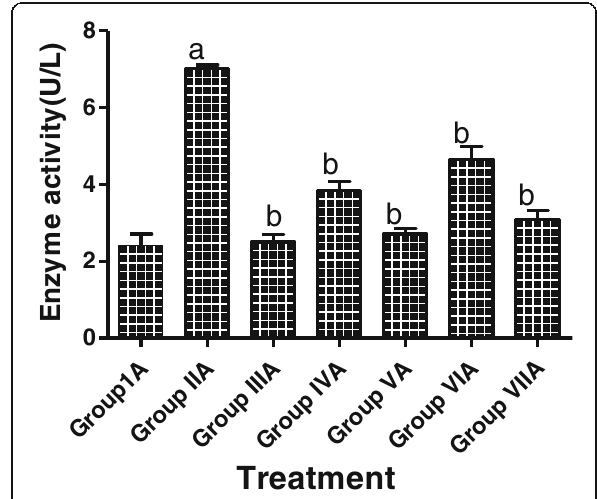
Fig. 2 Effect of methanol extract of T. conophorum seeds on Gamma gtutamyl transferase activities in CCl 4 induced hepatotoxicity in rats after 24 h of intoxication. Values are Mean±SEM, n =5 rats in each group. p <0.05, a as compared with the normal control group; b as compared with the CCl 4 only (group IIA) . γ -GT – Gamma